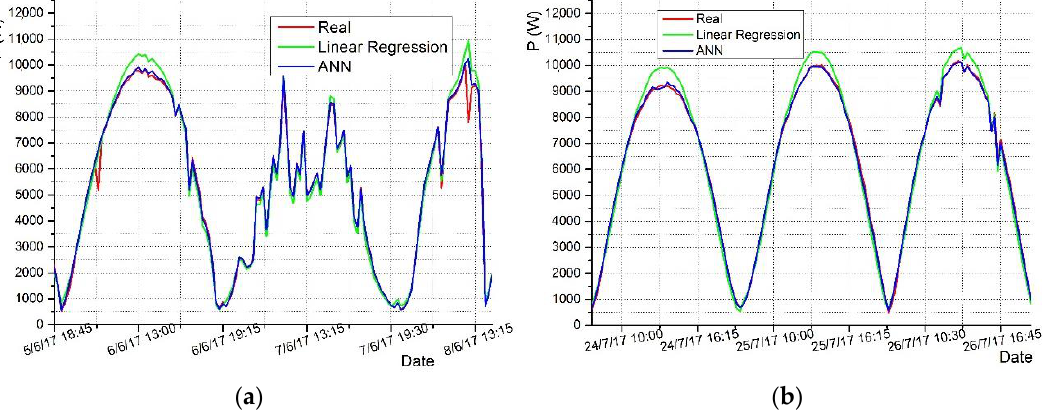
Figure 9. Comparison between actual power output and forecasts of the two alternative methods for three consecutive cloudy ( a ) and three sunny days ( b ), respectively, from 2016.